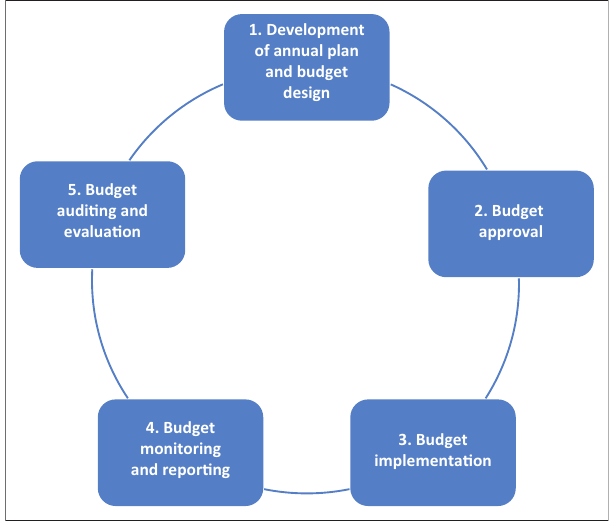
FIGURE 2: The budget life cycle of Union Parishads or union councils.